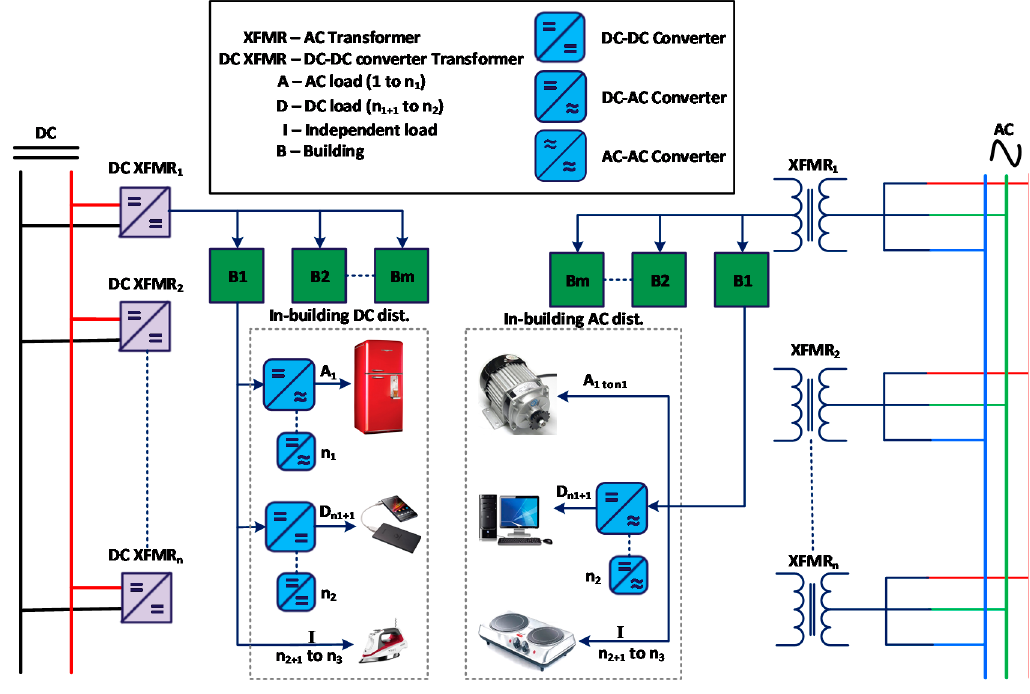
Figure 2. Overall system model.